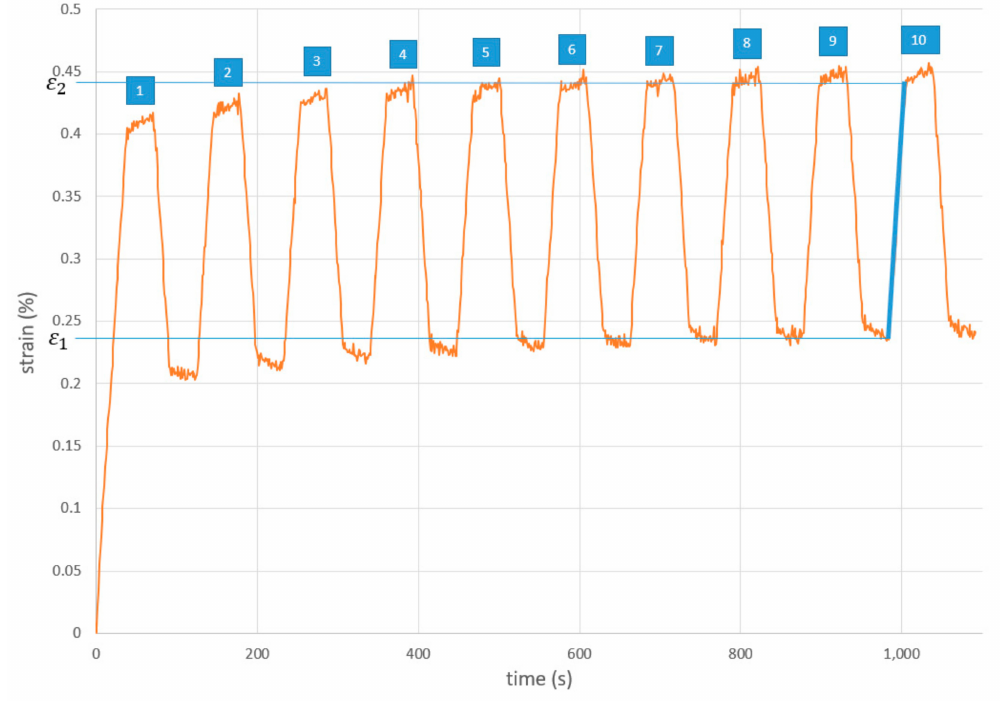
Figure 4. Alternating strains for determination of transverse modulus in z